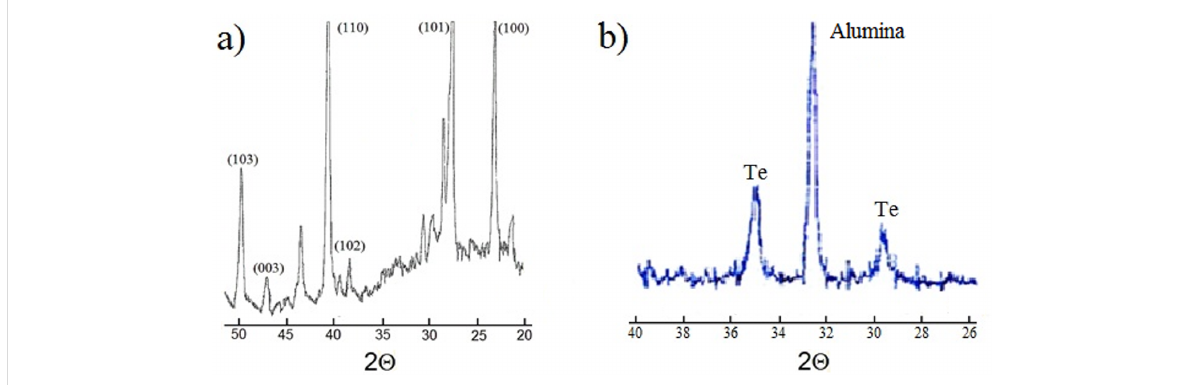
Figure 2: XRD diffraction patterns of Te films grown on Pyrex glass (A) or nanostructured Al 2 O 3 (B) substrates.